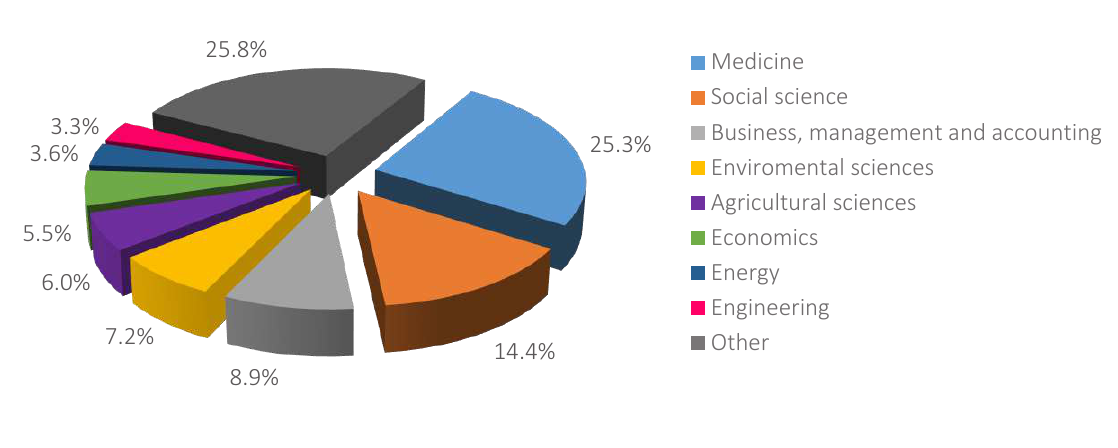
Figure 2. The initial analysis of documents by subject area